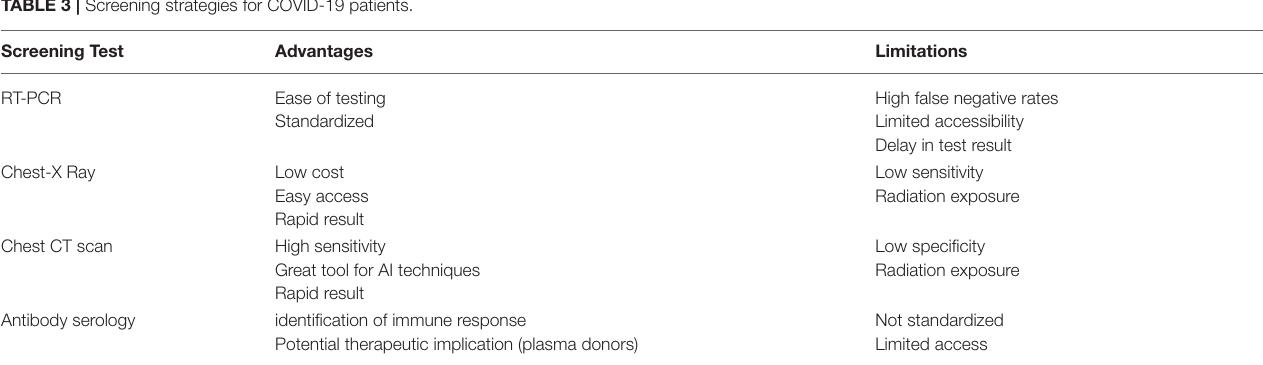
TABLE 3 | Screening strategies for COVID-19 patients. Screening